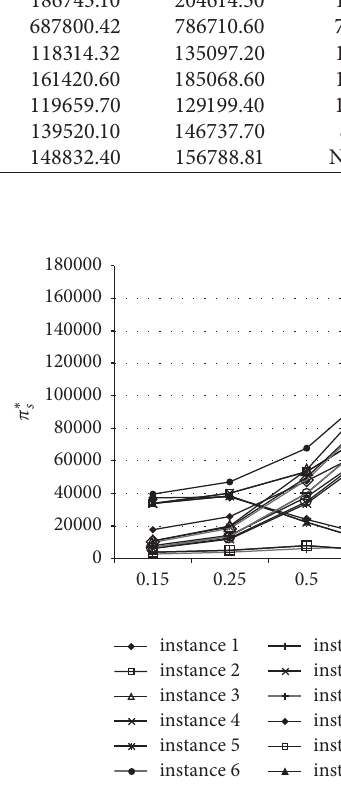
Figure 3: Manufacturer’ profit in the decentralized dual-channel supply chain for different instances.